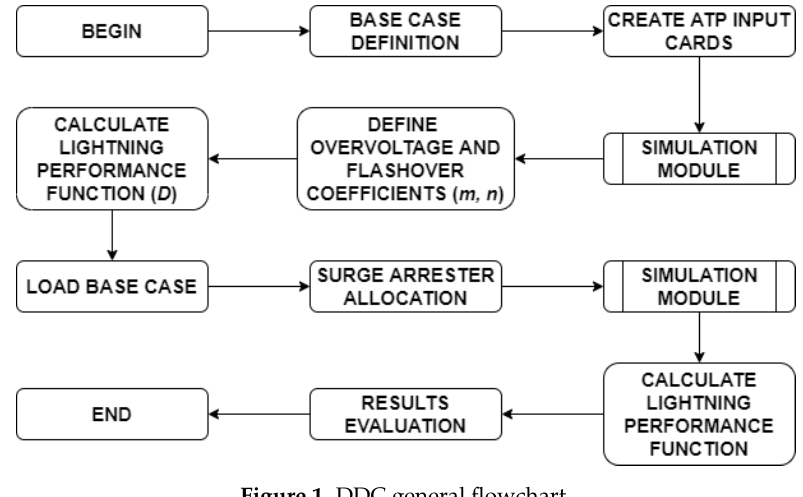
Figure 1. DDC general